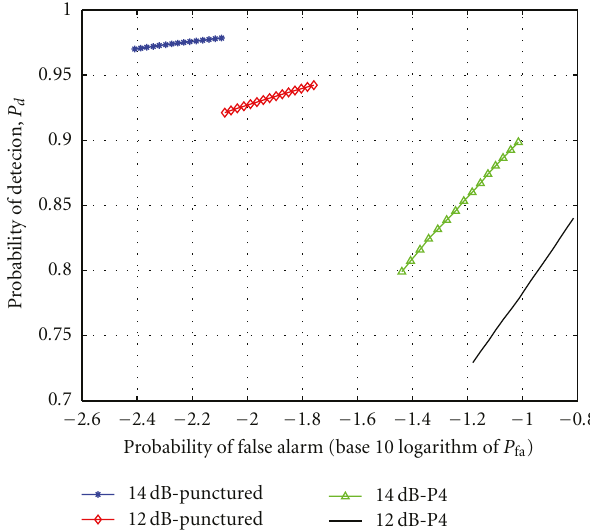
Figure 6: Probability of detection versus probability of false alarm of the coherent receiver: 124-length optimized punctured ZCZ sequence-pair versus 124-length P4